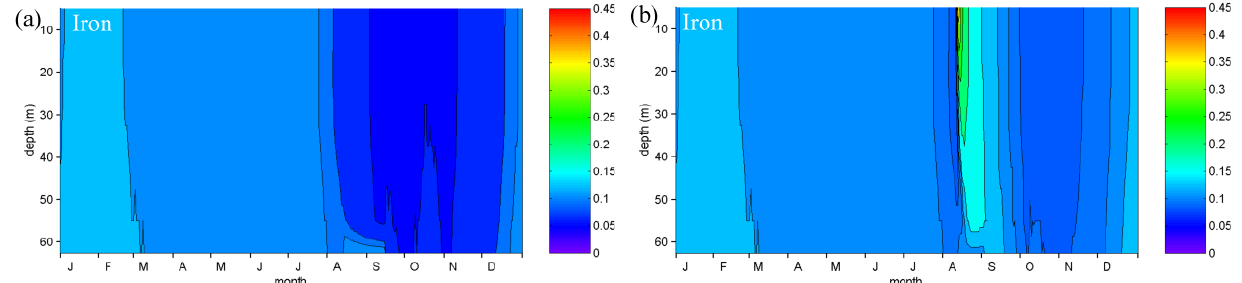
Fig. 8. Temporal evolution of the modelled vertical profile of dissolved iron in [nmolFeL − 1 ] in the upper 63m of the surface ocean at Papa during 2008 (a) without and (b) with iron fertilisation in August 2008.